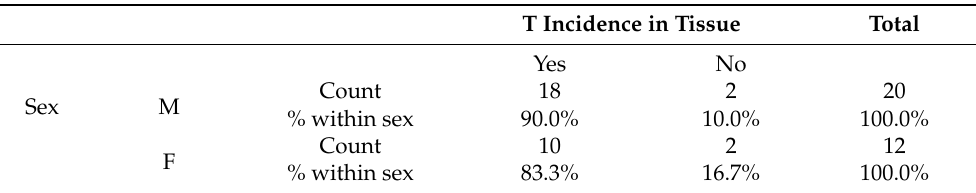
Table 9. Incidence of T in tissue